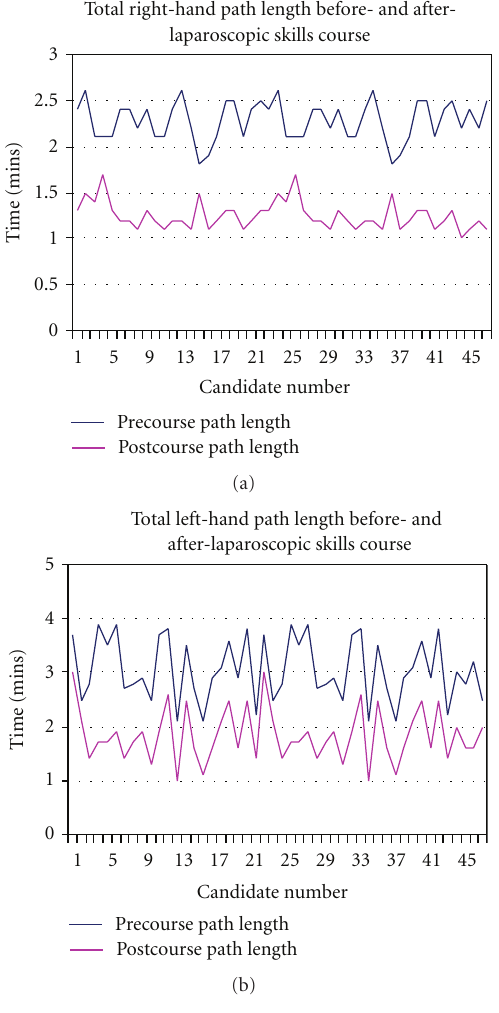
Figure 6: Total right- and left-hand